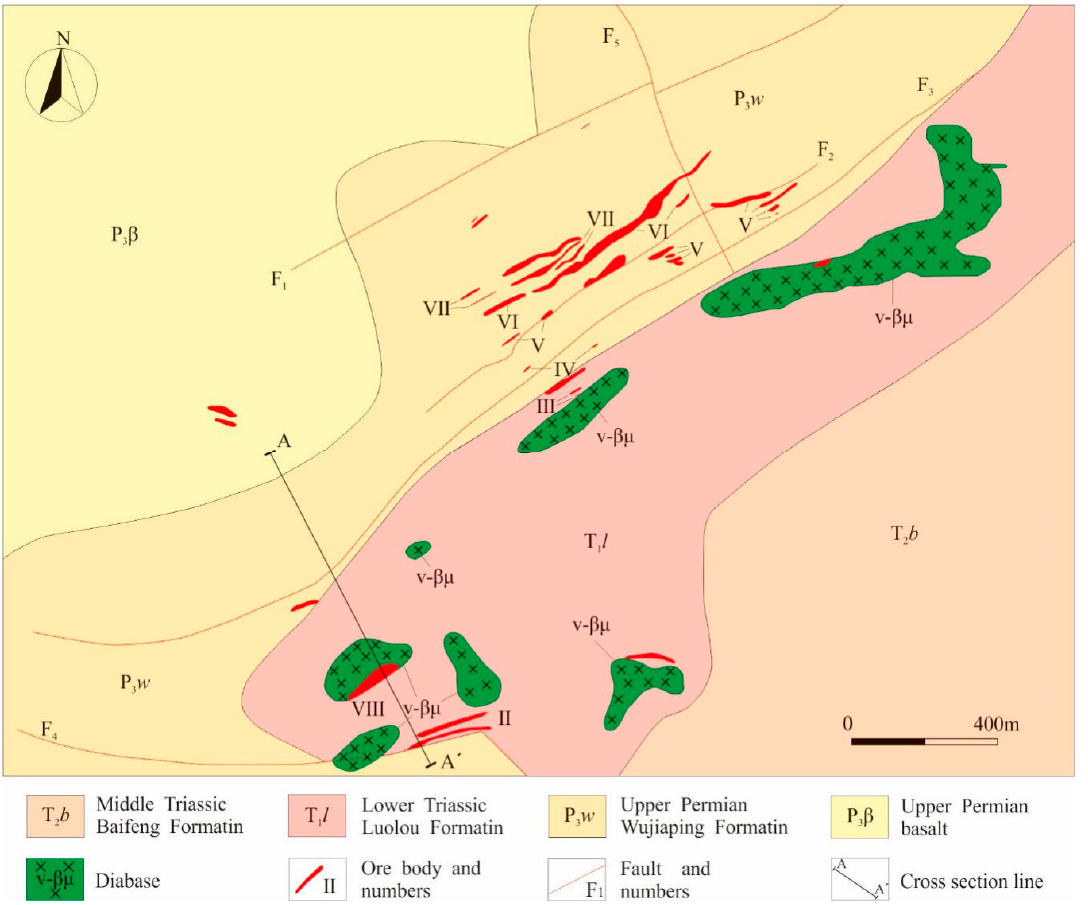
Figure 2. Geological map of the Zhesang gold deposit [39].